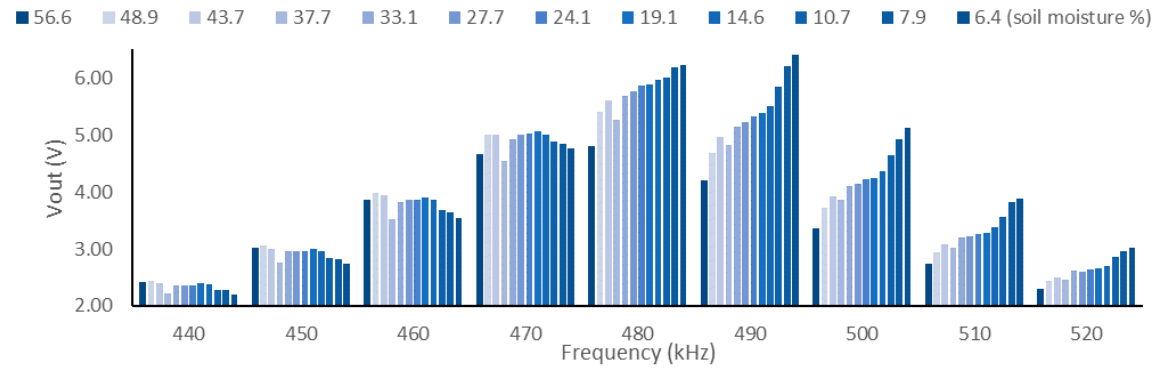
Figure 24. The Vout of prototype NP1 frequency 750 kHz.